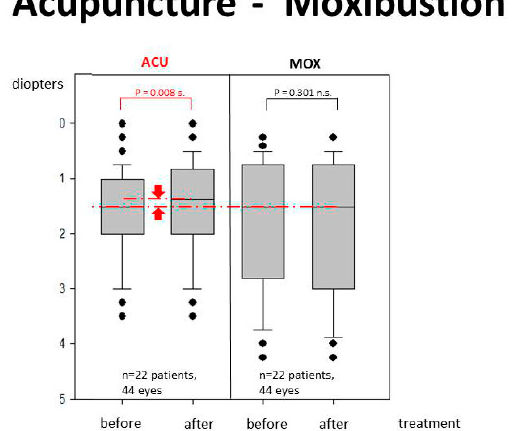
Figure 5. Box-plot of change in diopter values of all 44 subjects before and after treatment. The line in the box indicates the position of the median; the ends of the boxes define the 25th and 75th percentiles. The error bars show the 10th and 90th percentiles, and the dots represent “outliers”. Note the significance ( p = 0.008 s.) of the decrease in diopters after acupuncture treatment (left part).